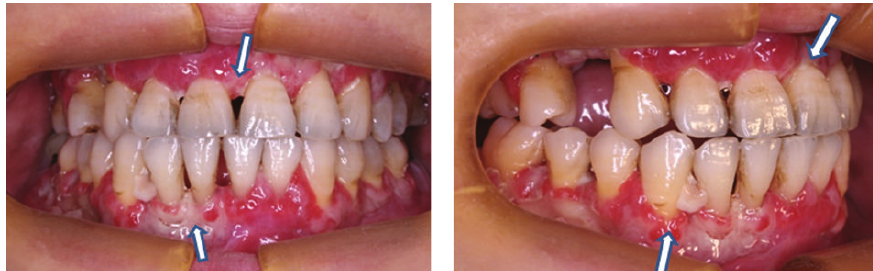
Figure 1: Generalized gingival swelling and redness with desquamation of necrotic tissue is observed (arrow).